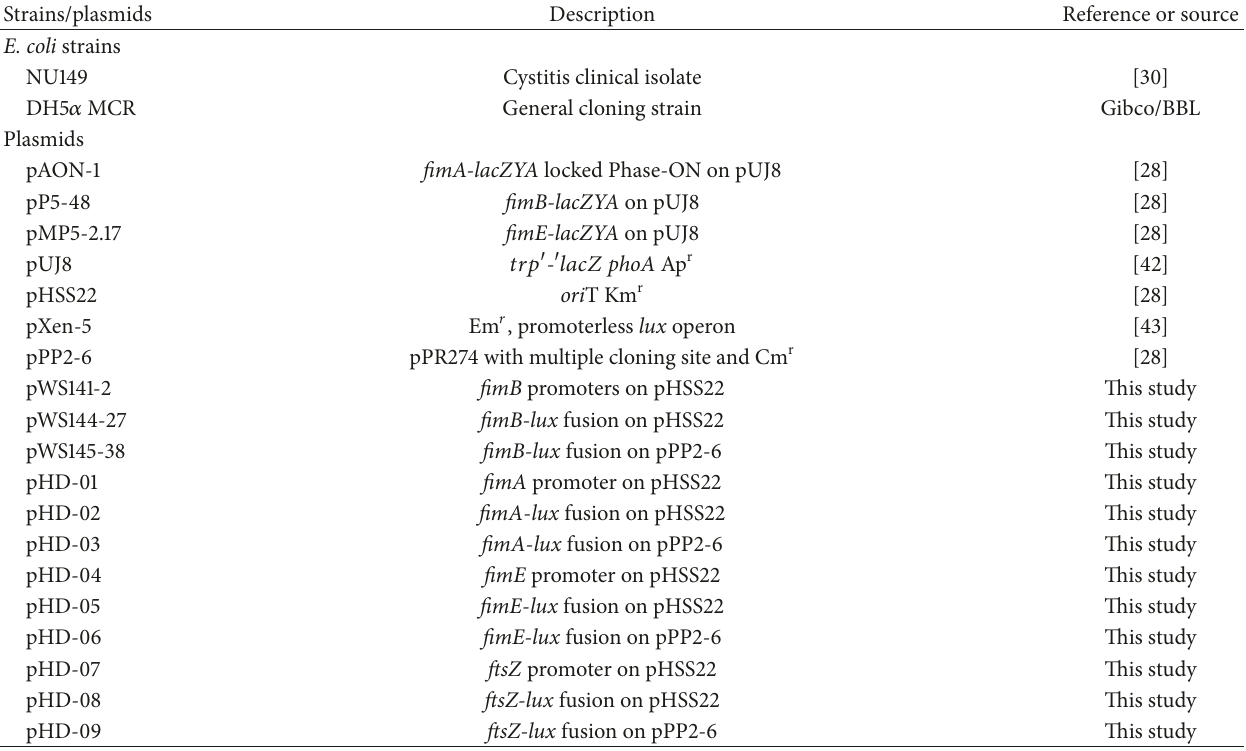
Table 1: Bacterial strains and plasmids used in this